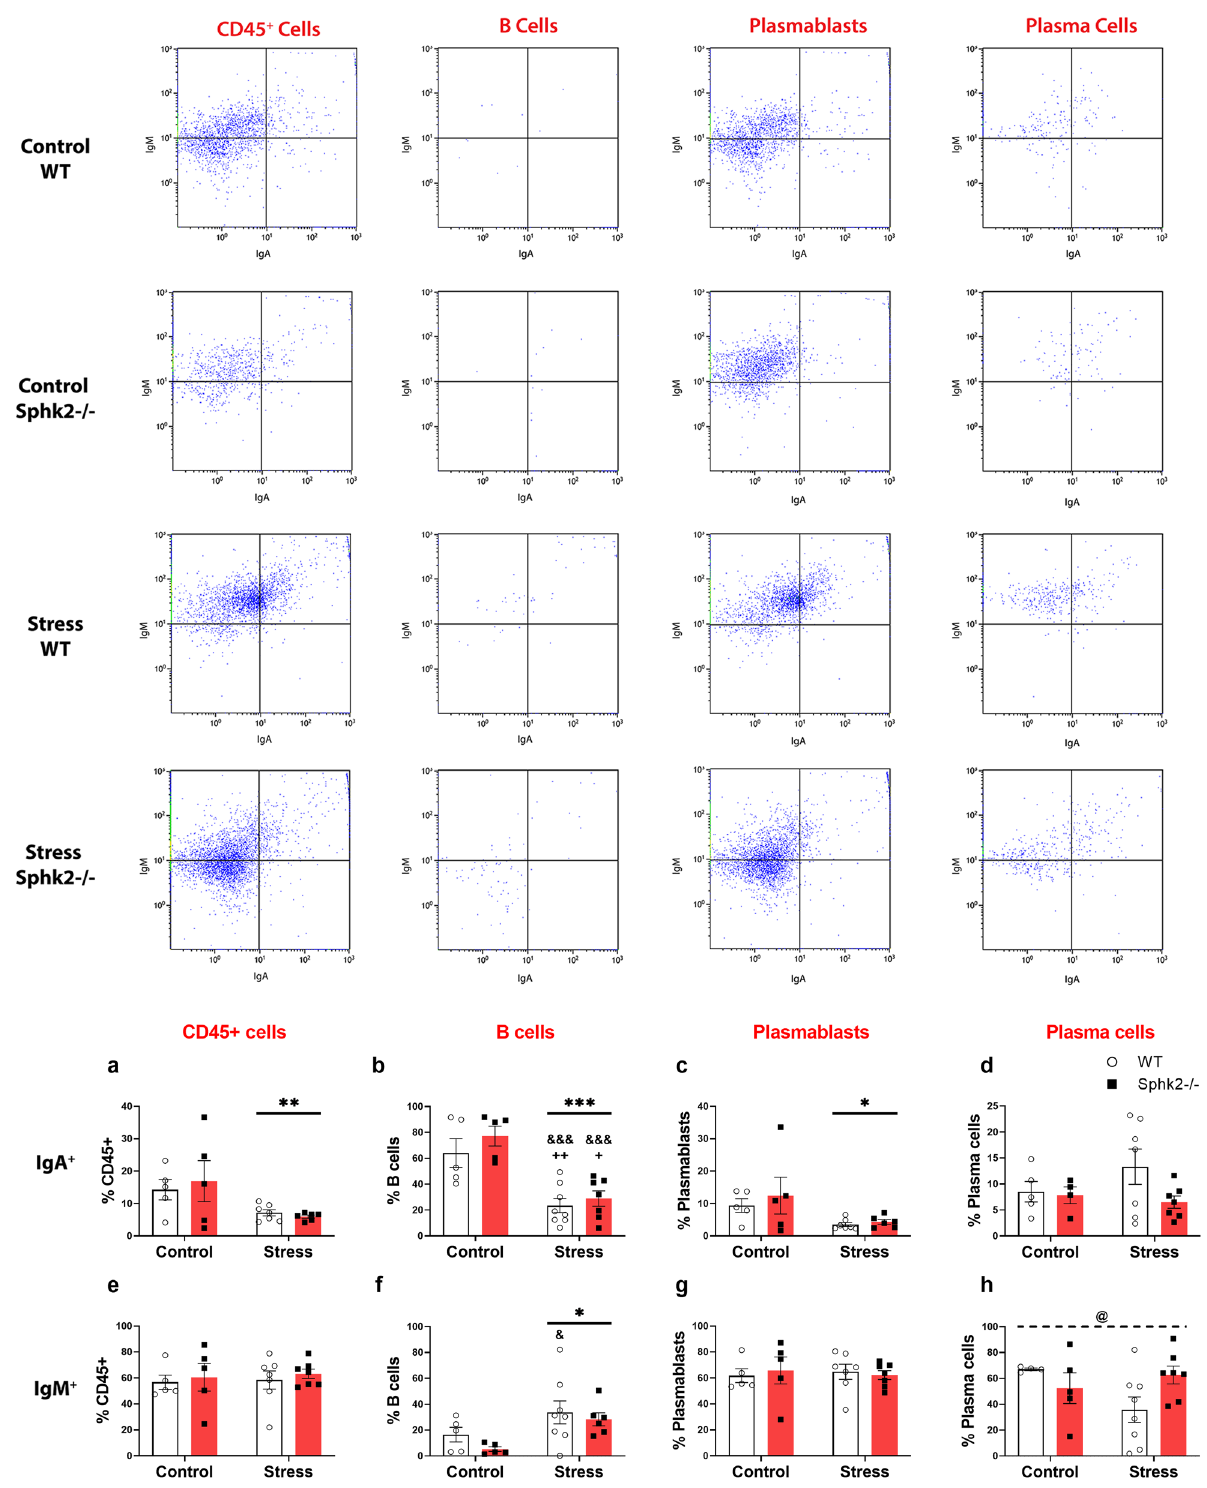
Figure 5. Flow cytometry analysis of IgA and IgM positive cells in different colon immune populations of WT and Sphk2−/− mice after stress exposure. Representative dot plots showing the gating strategy used to distinguish IgA−IgM−, IgA+IgM−, IgA−IgM+, and IgA+IgM+ in each cell population. Percentage of IgA+CD45+ ( a ), IgA+ B cells ( b ), IgA+ plasmablasts ( c ), IgA+ plasma cells ( d ), IgM+CD45+ ( e ), IgM+ B